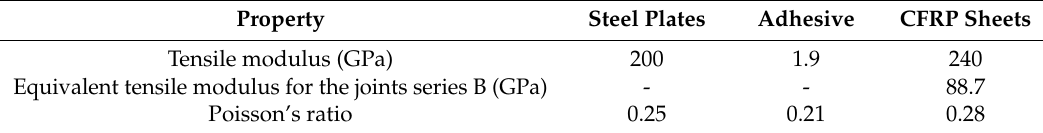
Table 4. Mechanical properties of materials used for joints series A and B [21,22]. Property